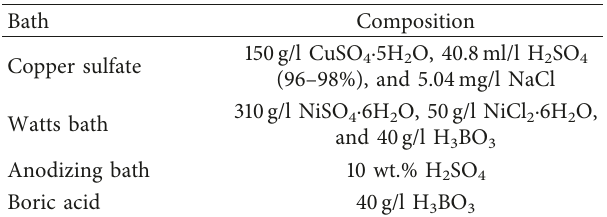
Figure 1: The two different sample holder setups for CNTmaterial based on (a) PVC and (b) a glass plate. Table 1: The composition of the copper deposition bath and CNT fiber pretreatment